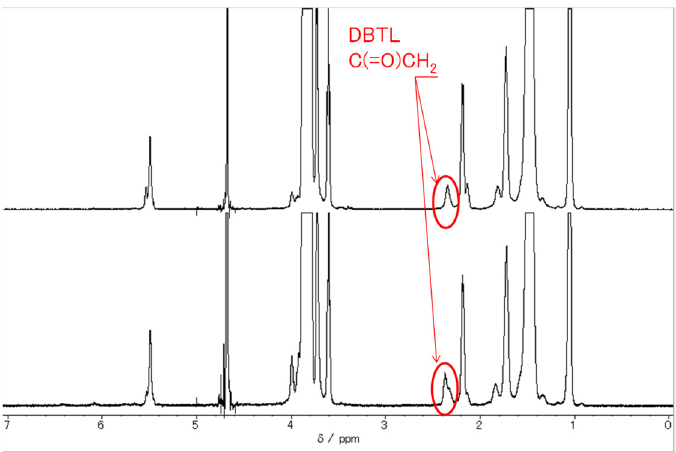
Figure 12. 1 H-NMR spectrum comparison of E212/DBTL (upper) and E230/DBTL (lower) at 50 °C.